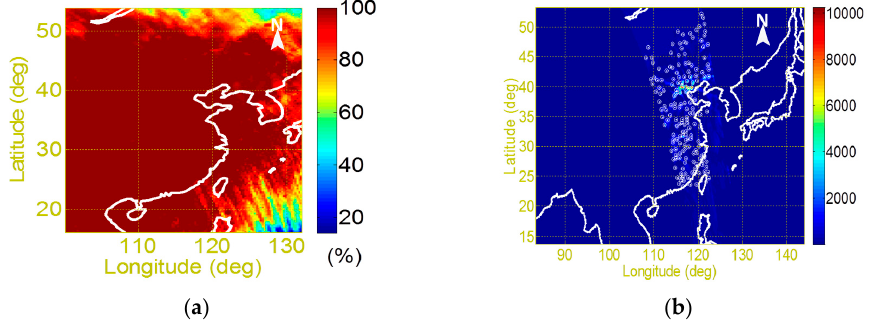
Figure A1. ( a ) RFI probability in parts of China (15 February–16 March 2011); ( b ) Detected distribution of the RFI sources based on the cluster selection.